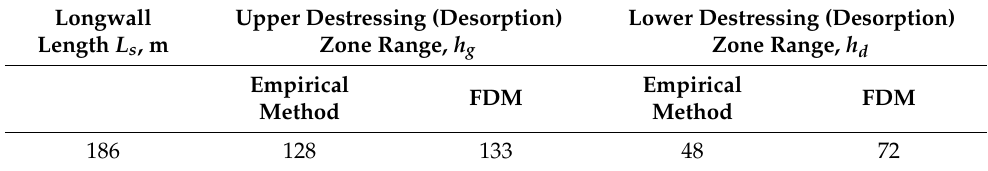
Table 2. Destressing zone range results for the FDM and empirical method calculations. Longwall Upper Destressing (Desorption) Length L s , m Zone Range, h